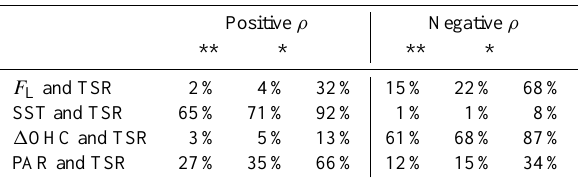
Table 3. Area proportions of Spearman’s rank correlation coeffi- cient ρ are shown between timing of sea ice retreat and F L , SST, (cid:49) OHC, and PAR, in the study region. Their spatial distribution is also shown in Fig. 4a–d. ∗∗ and ∗ denote p <0.05 and p <0.1, re-